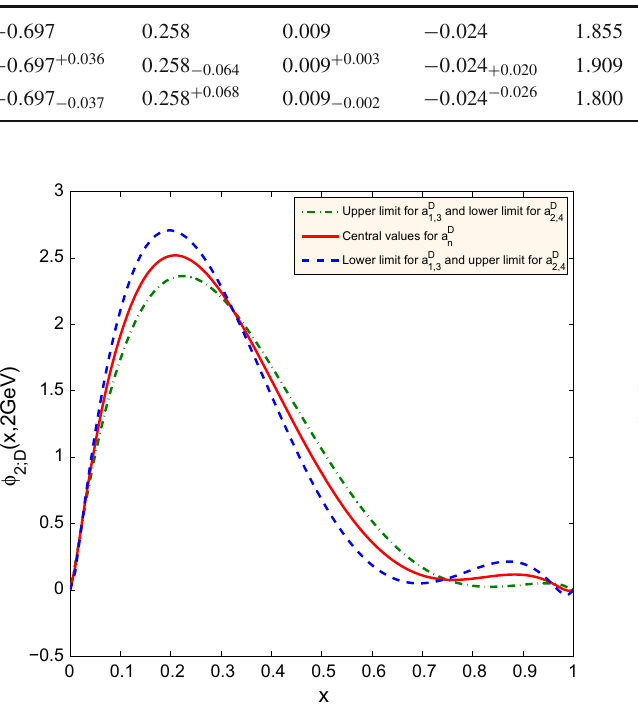
Fig. 6 The D -meson leading-twist DA model (11) at different scales, where the solid, the dashed, the dotted and the dash-dotted lines are for the scales μ = 2 , 3 , 10 , 100 GeV, respectively